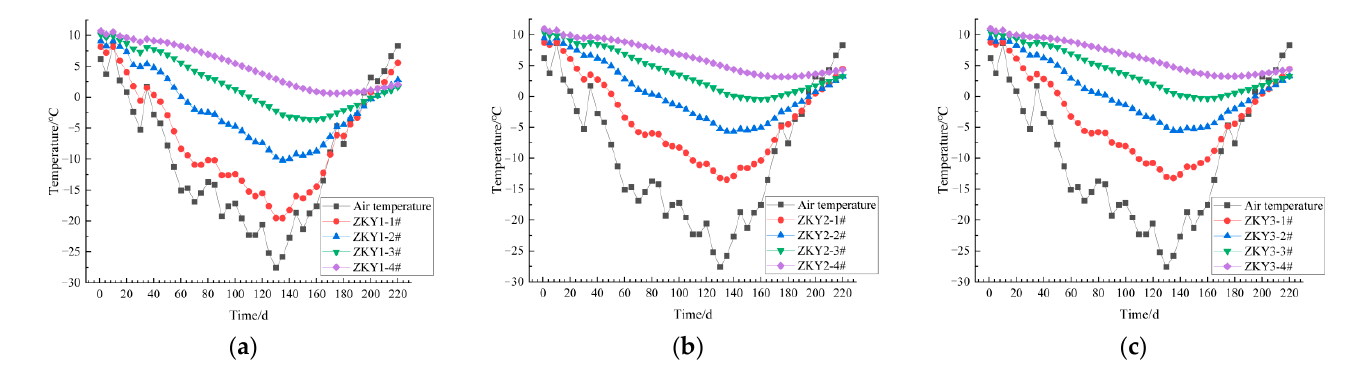
Figure 3. Temperature monitoring curves of each section. ( a ) Temperature monitoring curves of section ZKY1. ( b ) Temperature monitoring curves of section ZKY2. ( c ) Temperature monitoring curves of section ZKY3. Table 1. Monitoring values of frost heaving force at different time nodes (unit: